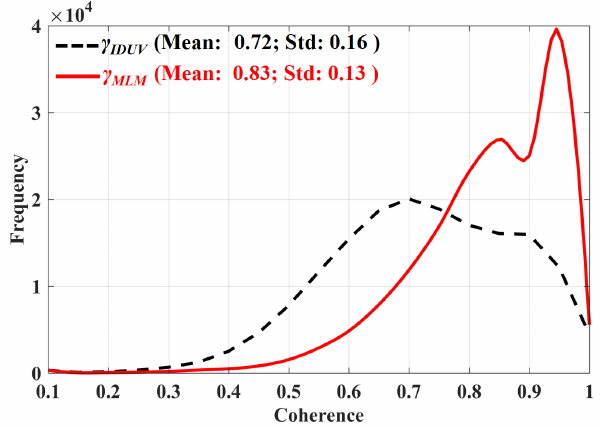
Figure 12. Histogram of the coherence images.